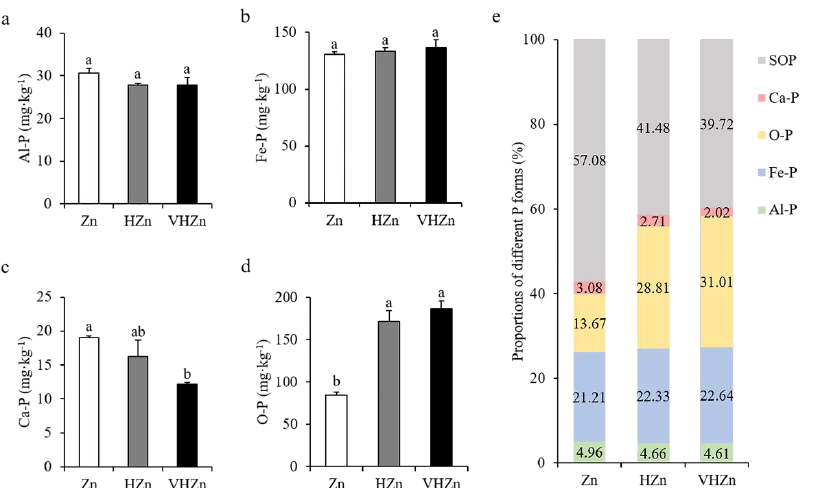
Figure 3. Concentrations ( a – d ) and proportions ( e ) of different P forms in rice rhizosphere soil with different levels of Zn (Zn: 10 mg · kg − 1 soil; HZn: 200 mg · kg − 1 soil; VHZn: 400 mg · kg − 1 soil). Al-P, aluminum bound P; Fe-P, iron bound P; Ca-P, calcium bound P; O-P, occluded P; SOP, soil organic P. Data are means ± SD of three biological replicates. Different letters indicate significant difference at p < 0.05 by Tukey’s test.